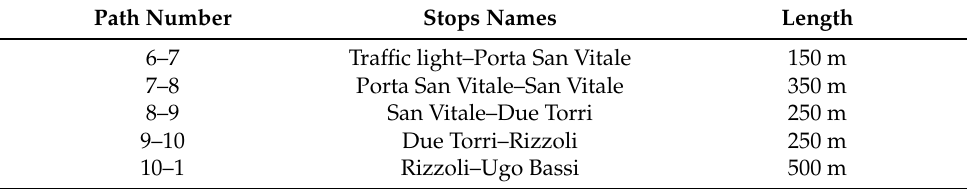
Table 2. Line 14—Return journey. Names of the trolleybuses’ stops and traffic light on the initial route.